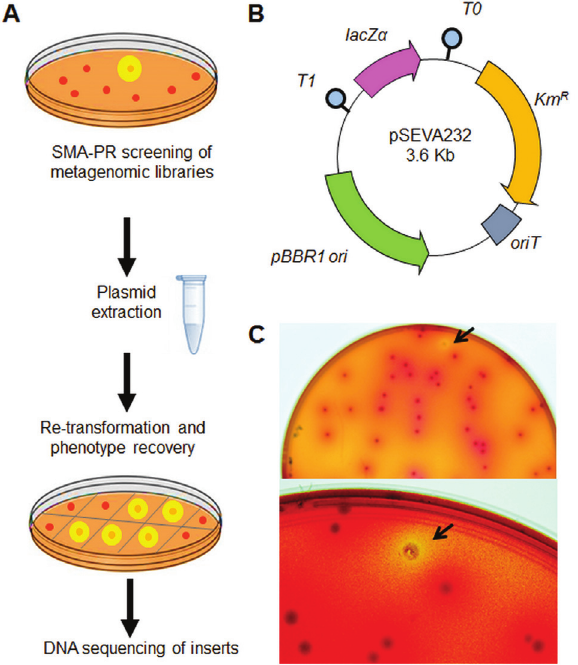
Figure 1 - Schematic representation of the workflow for finding novel en- zymes (proteases and GHs) using skimmed milk agar (SMA) and phenol red as pH indicator. ( A) Schematic workflow showing functional me- tagenomic screening, selection of positive clones, checking of phenotype maintenance and sequencing of the metagenomics inserts. (B) Overall or- ganization of the structure of pSEVA232 plasmid. Plasmid backbone in- cludes antibiotic resistance marker ( KmR ), conjugation origin ( oriT ), broad host-range origin of replication (pBBR1), T1 and T0 transcriptional terminators and lacZ (cid:2) reporter, which contains a multiple cloning site (MCS) where metagenomic fragments were placed. (C) Plate of SMA-PR media after incubation at 37 ºC for 24 h. Arrow indicates a colony of E. coli surrounded by a yellow halo and identified as positive